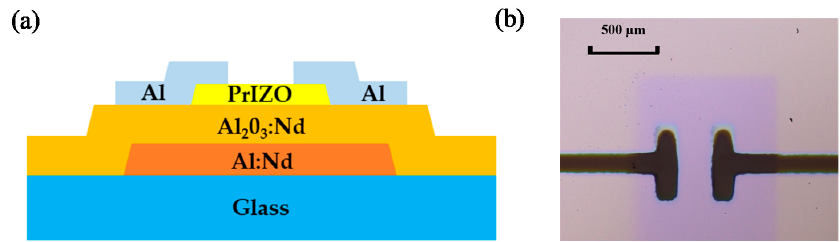
Figure 1. Praseodymium-doped indium-zinc-oxide (PrIZO) thin film transistor (TFT) ( a ) schematic cross-sectional view, ( b ) micrograph.